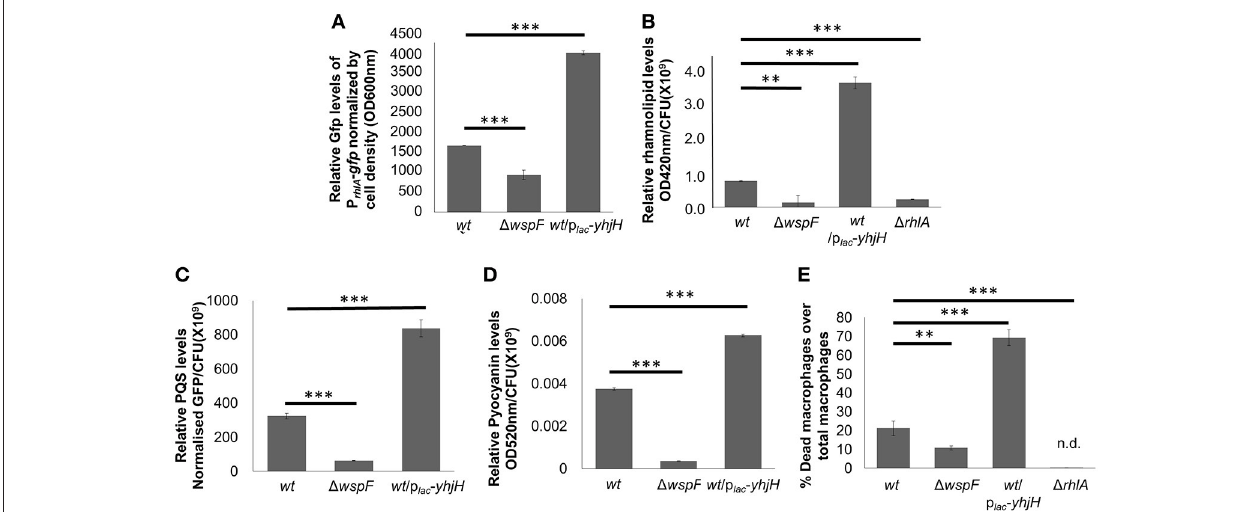
FIGURE 3 | Induction of QS-controlled virulence factors in low intracellular c-di-GMP containing P. aeruginosa /p lac -yhjH mutant. Relative quantification of P rhlA - ASV (A), rhamnolipids (B), PQS (C) and pyocyanin (D) in PAO1, 1 wspF mutant and P. aeruginosa /p lac -yhjH mutant. (E) Cytotoxicity of P. aeruginosa /p lac -yhjH and 1 wspF to macrophages. Means and s.d. from triplicate experiments are shown. ** P < 0.01, *** P < 0.001, One-way ANOVA.